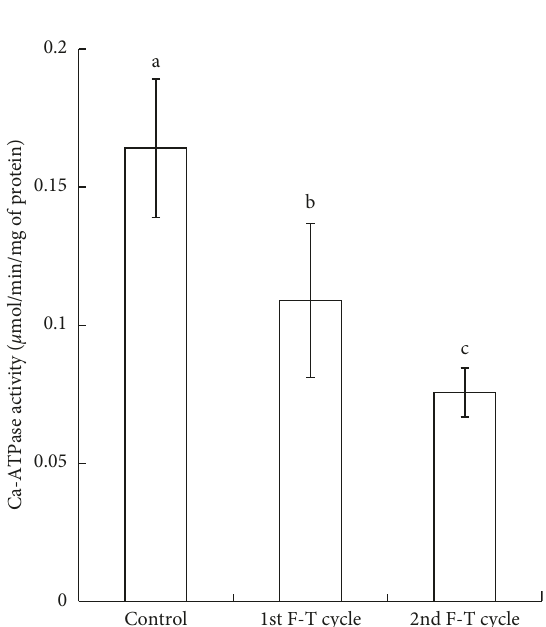
Figure 10: Ca-ATPase activity of each frozen surimi. Error bar indicates standard deviation. Different letters indicate a significant difference ( p < 0 .